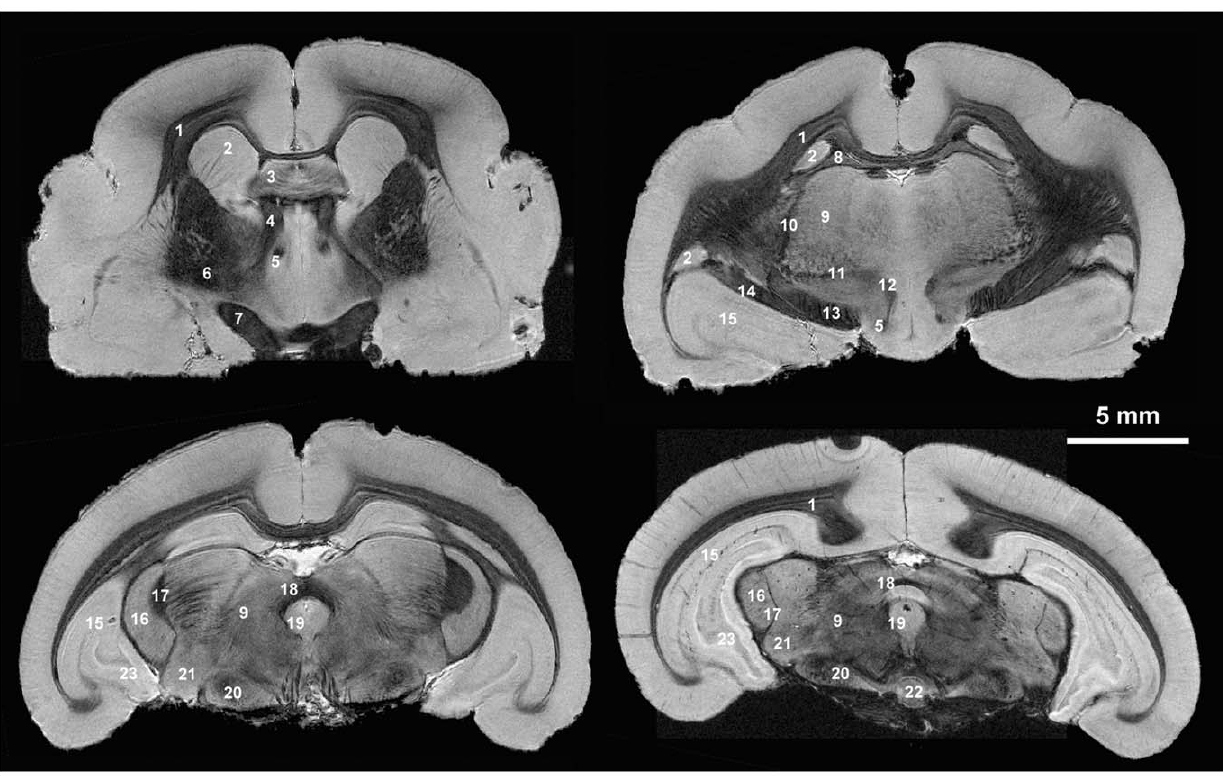
Figure1. High-resolution MR images of the mouse lemur brain at 7T. 1: corpus callosum; 2: caudate nucleus; 3: septal nuclei; 4: thalamic medullary stria; 5: fornix; 6: lenticular nucleus; 7: optic chiasm; 8: hippocampal fimbria; 9: thalamus; 10: external medullary lamina; 11: Forel’s field; 12: mamillo-thalamic tract; 13: cerebral peduncle; 14: optic tract; 15: hippocampus; 16: lateral geniculate body; 17: median lemniscus; 18: posterior commissure; 19: central grey matter; 20: substantia nigra; 21: medial geniculate nucleus; 22: central interpedoncular nucleus; 23: dentate gyrus. Based on [32].